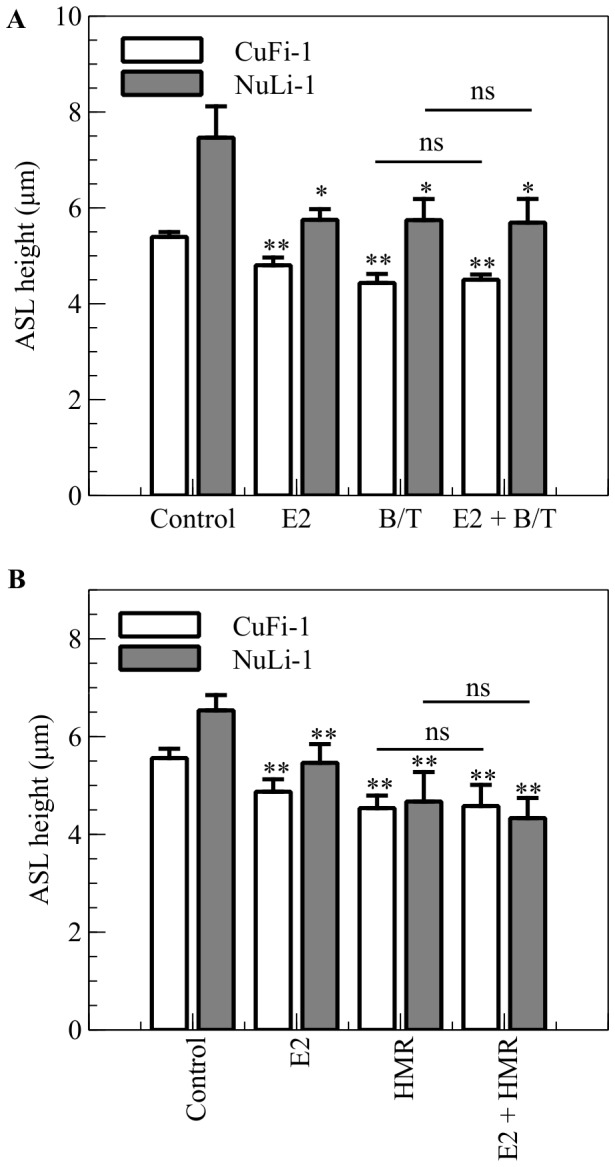
E2 inhibits K+ recycling in normal and CF bronchial cell lines.A. NuLi-1 (grey bars) and CuFi-1 (white bars) epithelial monolayers were stained with Calcein Green and ASL was stained with dextran conjugated to Texas RedTM fluorochrome and ASL height was measured after treatment with E2 (30 min, 1 nM), and a cocktail of BaCl2 and TEA to inhibit potassium channels (B/T 30 min, BaCl2 10 mM, TEA 1 mM) or pretreated with E2 and then treated with the K+ channels cocktail inhibitor (E2 + B/T) (n = 5, Error bars reflect standard error of the mean, ANOVA, * p<0.05, ** p<0.01). B. NuLi-1 (grey bars) and CuFi-1 (white bars) epithelial monolayers were treated with E2 (30 min, 1 nM), and the KCNQ1 channel specific inhibitor HMR1556 (HMR, 30 min, 1 µM) or pretreated with E2 and then treated with HMR1556 (E2 + HMR) (n≥3, Error bars reflect standard error of the mean, ANOVA, ** p<0.01).